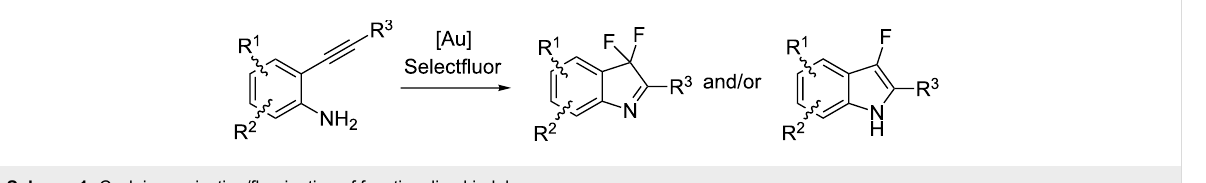
Scheme 1: Cycloisomerization/fluorination of functionalized